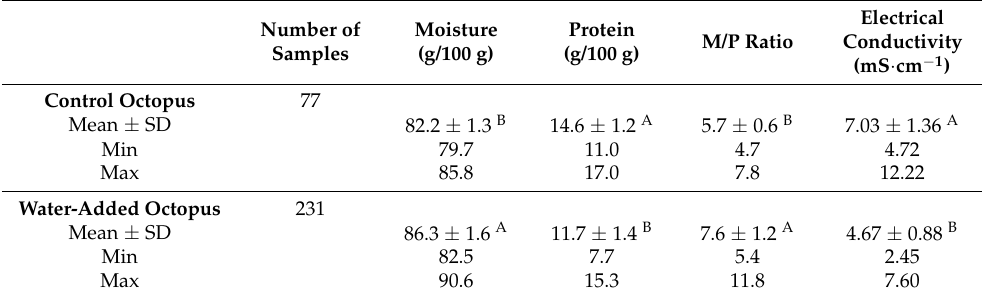
Table 1. Characterization of Octopus vulgaris samples used in water addition trials for the calibration of TDR analysis. Water-added samples were immersed in freshwater for 0.5 to 32 h. Different superscript letters (A, B) denote significant differences between control and water-added